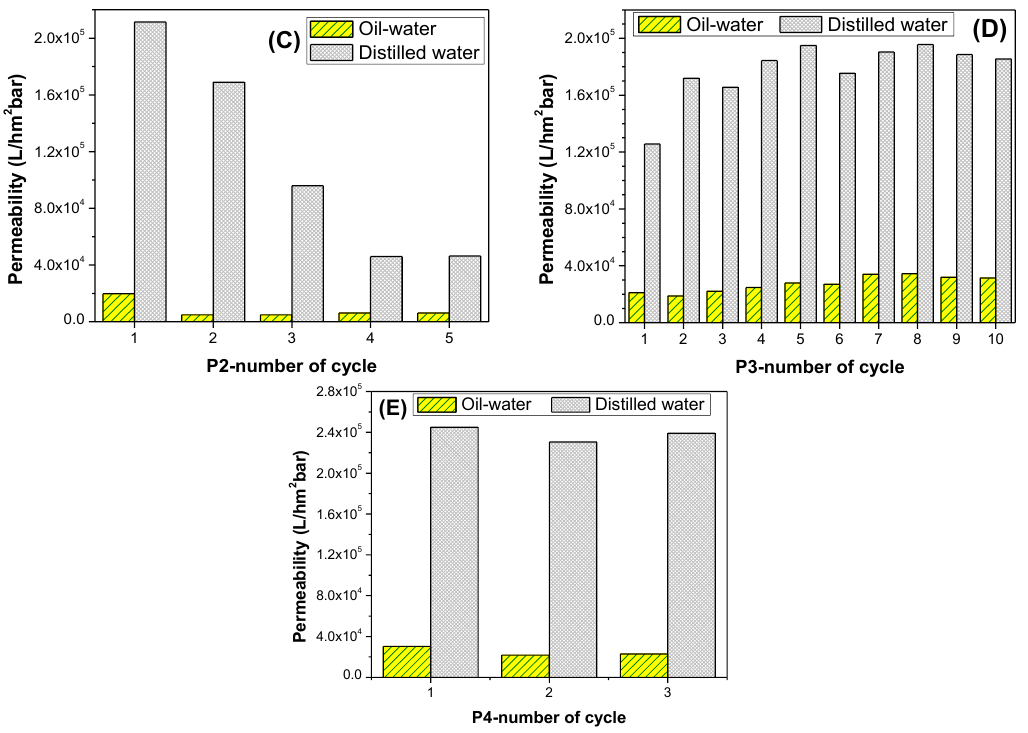
Figure 7. Repeated fouling and self-cleaning experiments of samples ( A ) P0, ( B ) P1, ( C ) P2, ( D ) P3, and ( E ) P4.